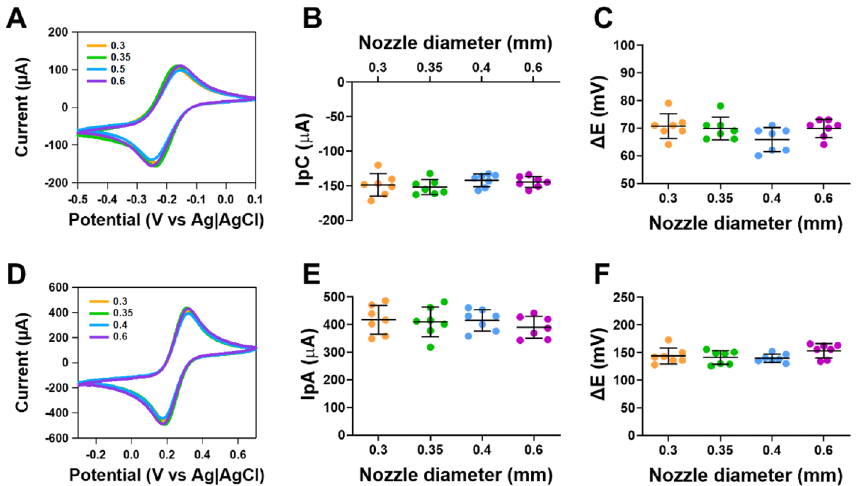
Figure 1. Responses of 3D printed CB/PLA electrodes at different nozzle diameters on outer and inner sphere redox probes. ( A ) Representative cyclic voltammograms of 1 mM ruthenium hexamine in 1 M KCl at 0.05 V s −1 , ( B ) Cathodic peak current, ( C ) ΔE of ruthenium hexaamine ( D ) representative cyclic voltammograms of 5 mM ferricyanide in 1 M KCl at 0.05 V s −1 , ( E ) anodic peak current and ( F ) ΔE of ferricyanide. All electrodes were printed at 230 °C extruder temperature and heated bed temperature of 50 °C. Data shown as mean ± SD, where n =